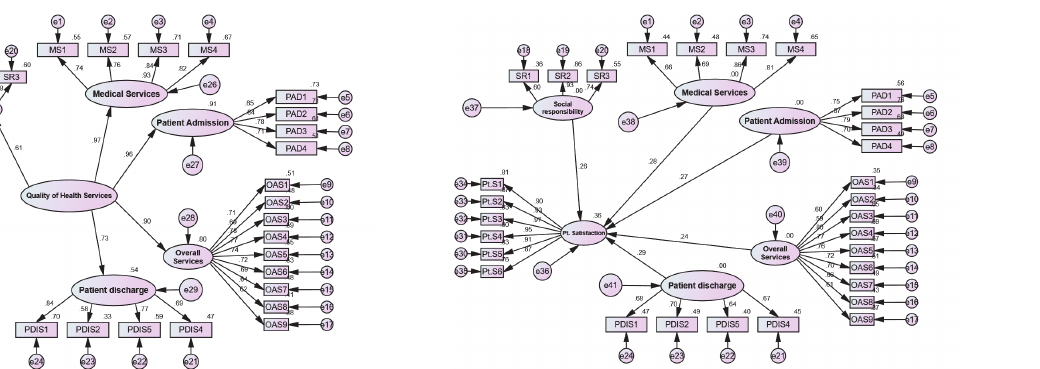
Fig. 2. The second-order CFA Quality of Health Ser- vices(QHS)